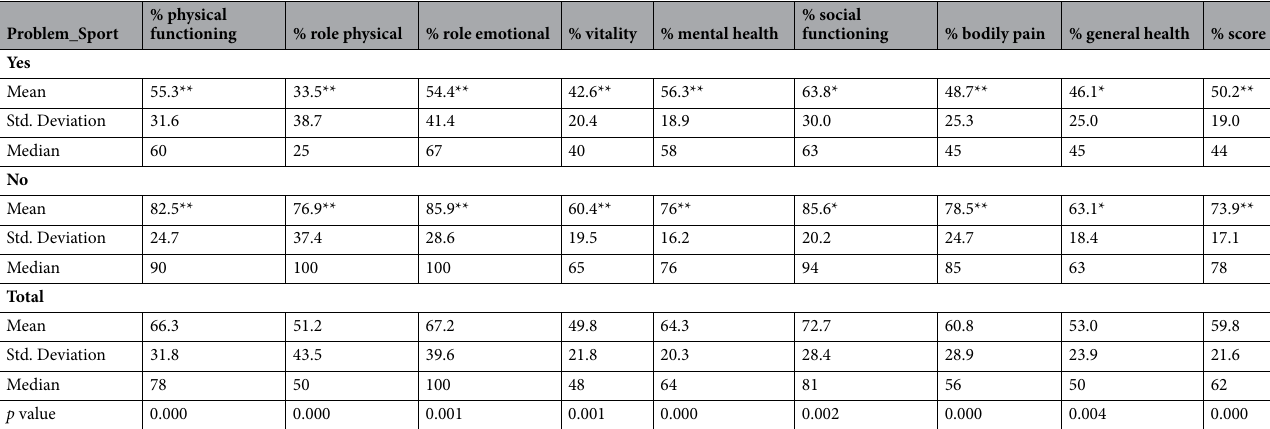
Table 2. Assessment of quality of life using the self-reported SF-36 survey depending on difficulties encountered performing sport activities. Note the significant differences in scores in all categories for patients encountering problems in performing sport activities and returning to daily living activities. * p < 0.005; ** p < 0.001.